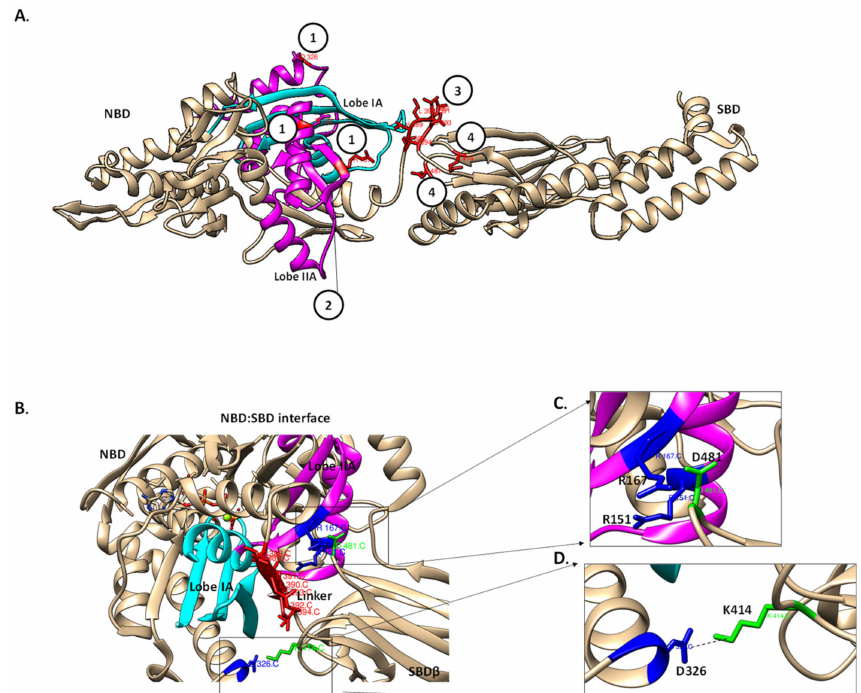
Figure 7. The potential Hsp70 allosteric hotspots for drug targeting. The model of Hsp70 potential drug target sites that are modulated by the linker. ( A ) Hsp70 major allosteric hotspots located are shown in red. (1) NBD residues involved in the formation of the NBD–SBD interface (R151, R167 and D326 based on DnaK numbering); (2) the linker binding cleft between lobe IA (magenta) and IIA (cyan) form the hydrophobic linker binding cleft which is crucial for linker docking in the ATP state; (3) linker residues such as V389 and D393, hence, are also crucial for the NBD–SBD interface formation and (4) SBD residues, K414 and D481 (based on DnaK) that are crucial in the formation of the NBD–SBD interface [51]. ( B ) The NBD–SBD interface is shown with the allosteric hotspots in the NBD (blue) and SBD (green), respectively. The linker docked onto the linker binding cleft facilitates the formation of the NBD–SBD interface. NBD residues R167, R151 (blue) and the SBD (green) residue D481 form a part of NBD–SBD [51] ( C ), while NBD residues, D326 and K414 interact through hydrogen bonding